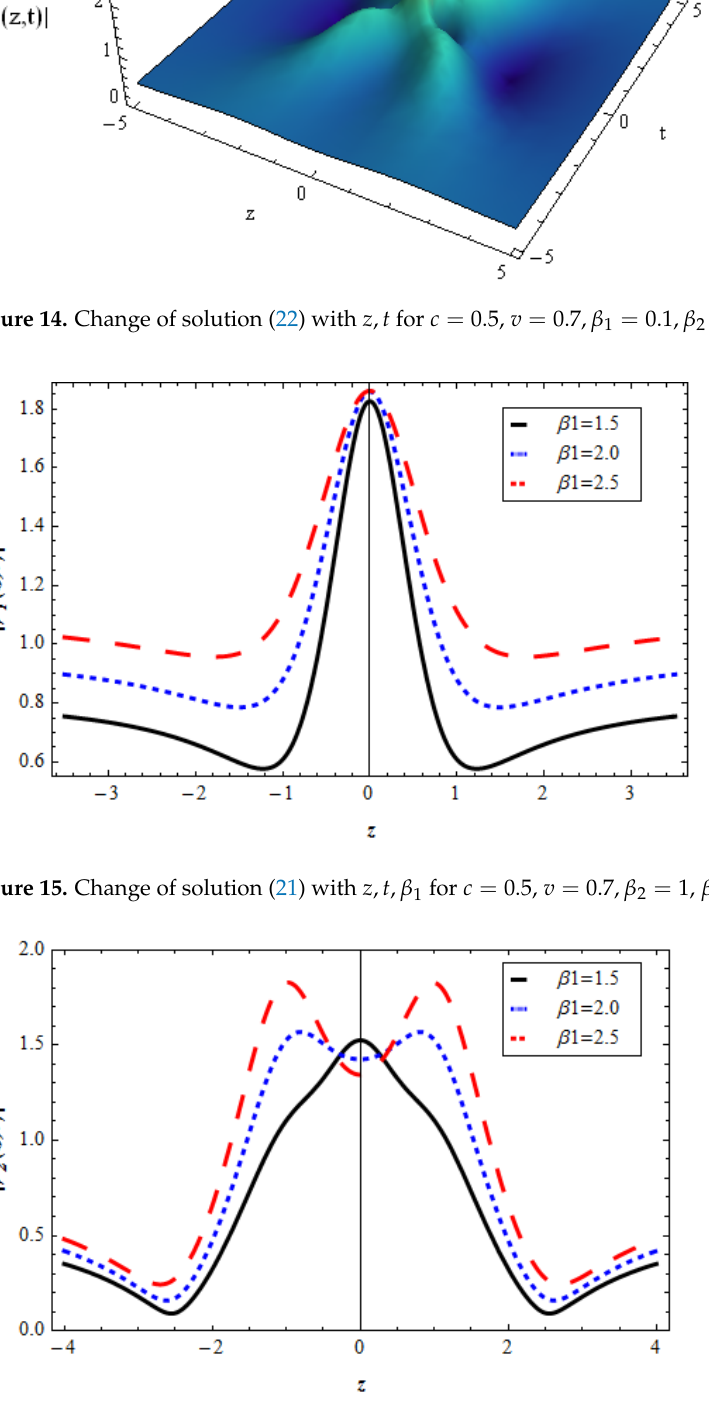
Figure 16. Change of solution (22) with z , t , β 1 for c = 0.5, v = 0.7, β 2 = 1, β 3 = 0, β 4 =